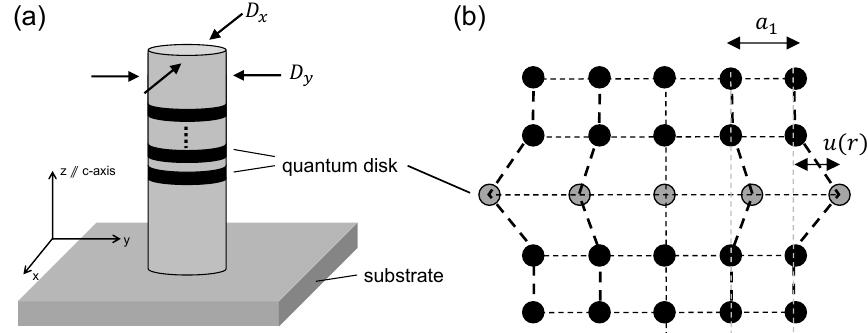
Figure 1. ( a ) The schematic of a dot-in-wire structure, as considered in this work. Multiple identical quantum disk regions are embedded in a nanopillar along the crystal c-axis. The quantum confinement is in the z direction. The nanopillar can have different dimensions in the x and y directions. If they are the same, we denote D = D x = D y . ( b ) The classical lattice model used in this work. The quantum disk region is modeled by a single-layer one-dimensional chain of lattice points. The lvariable u ( r ) is defined as the displacement of the lattice point with respect to the fully strained position. The quantum disk region is allowed to relax in the radial direction. The lattice points in the barrier are not allowed to